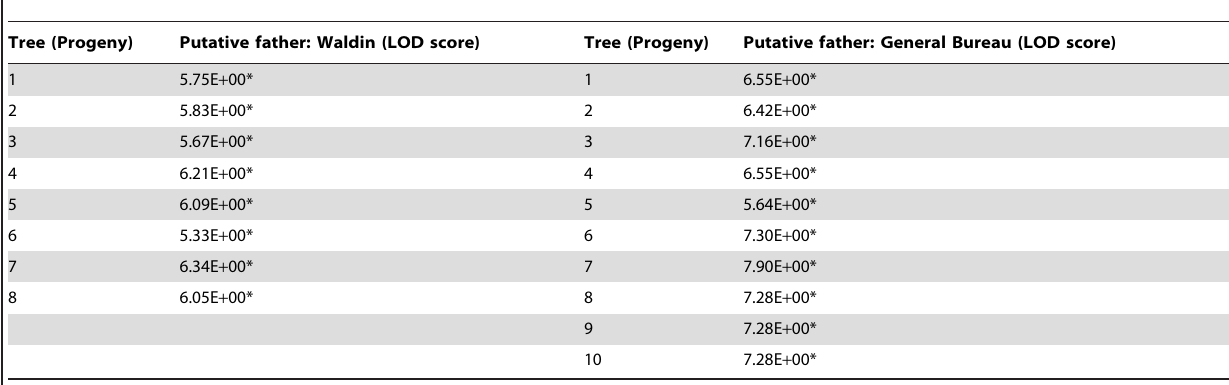
Table 1. Summary results of the paternal parentage analysis using microsatellite markers on Melendez offspring.